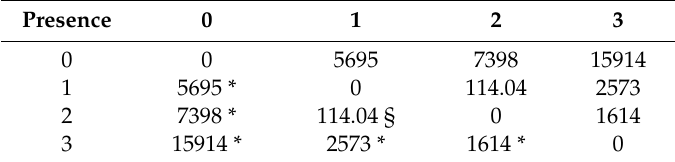
Table 7. The significance of Mahalanobis distances between uninfected and diseased Italian lemon and Valencia orange plants.